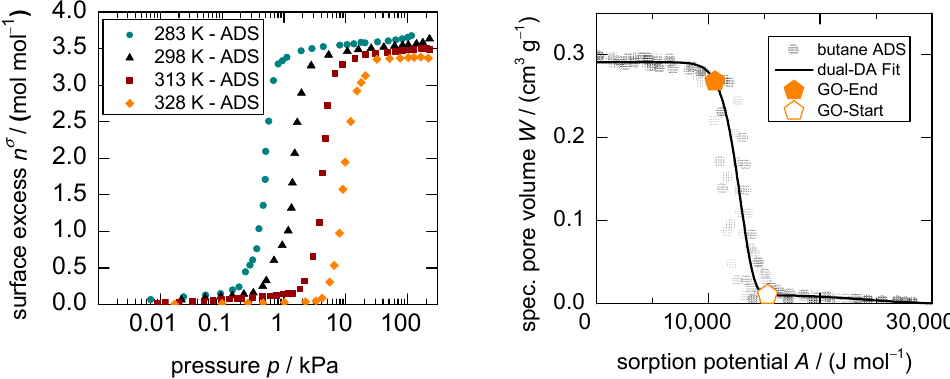
Figure 1. Adsorption isotherms for the system n -butane on 1 at 283, 298, 313, and 328 K in a logarithmic pressure scale ( left ) and the resulting Dubinin plot using the corresponding states theory for all temperatures, including the GOS- and GOE- points ( right ).